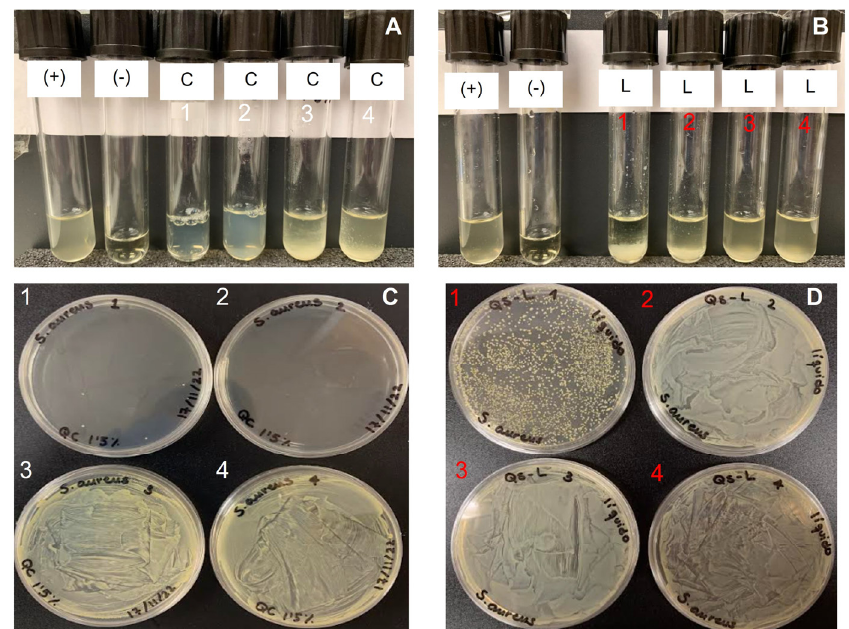
Figure 10. Antimicrobial activity of crab chitosan (C) in a broth macrodilution assay against S. aureus ( A ). Antimicrobial activity of lobster chitosan (L) in a broth macrodilution assay against E. coli ( B ). Growth on plates of crab chitosan assay ( C ) and lobster chitosan assay ( D ). In crab chitosan tube 1: 1.5 mg/mL, tube 2: 0.375 mg/mL, tube 3: 0.1 mg/mL and tube 4: 0.02 mg/mL. In lobster chitosan, concentrations for tube 1 to 4 were 3.34 mg/mL, 1.11 mg/mL, 0.37 mg/mL and 0.125 mg/mL respectively.